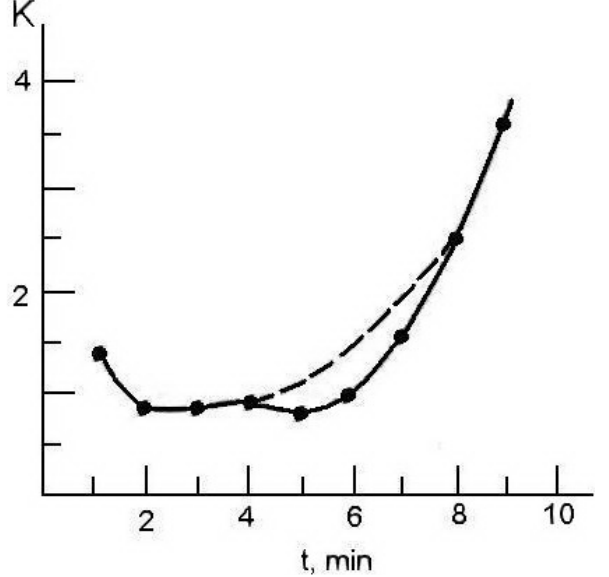
Figure 17. The mean variation of the red-to-green emission inten- sity ratio in dayside arcs (Vorobjev et al., 1988a).